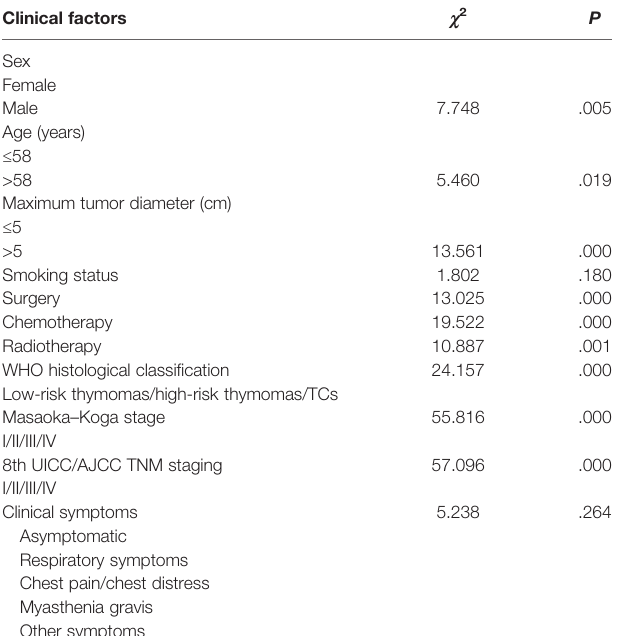
TABLE 2 | Univariate analyses of overall survival for 84 patients with TETs. Clinical